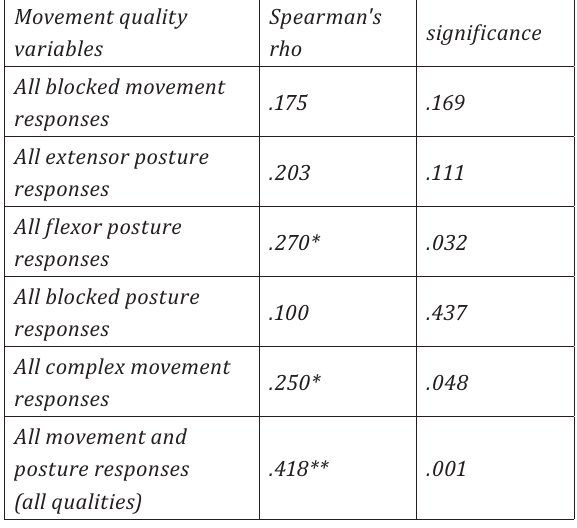
Table 10. The values of Spearman’s rho between the “chiaroscuro” variable and movement quality variables in the group of parents of normal children (N = 42)